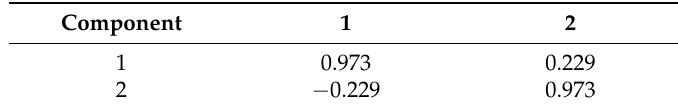
Table 8. Component transformation matrix for selected PCs.